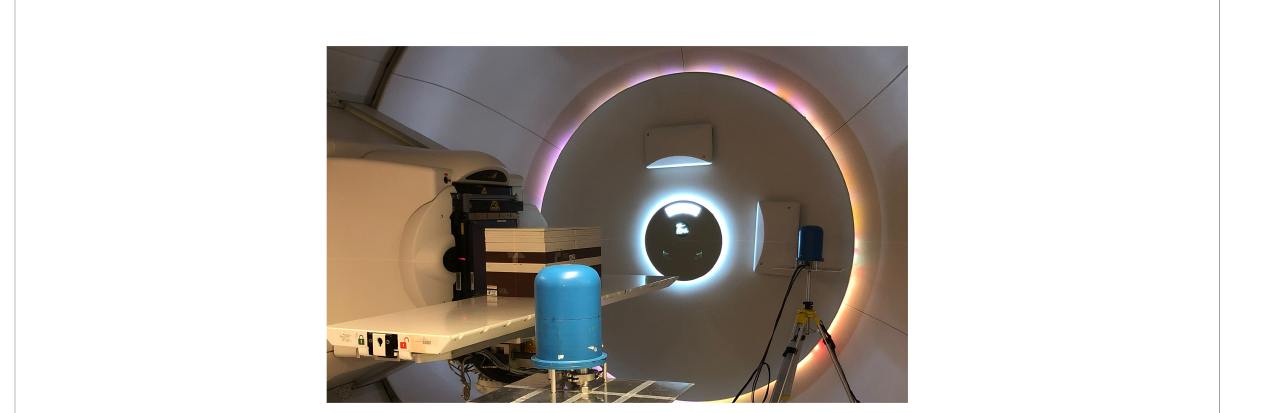
FIGURE 2 The experimental setup, with the two TEPCs in positions A and C. The C position is situated close to the gantry wall, while the A position in the foreground is facing the open treatment